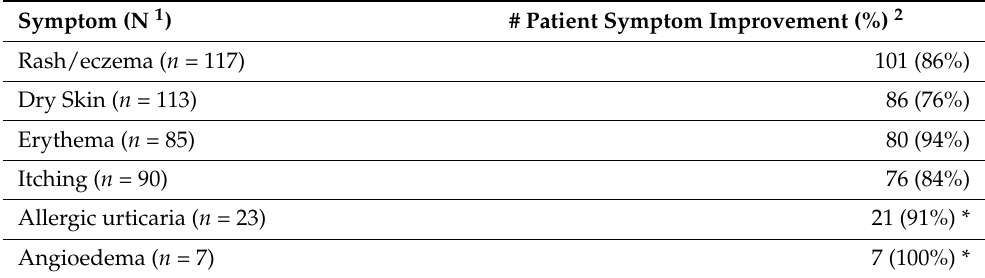
Table 3. Distribution of skin symptoms in infants ≤ 6 months of age with diagnosed or sus- pected CMPA.